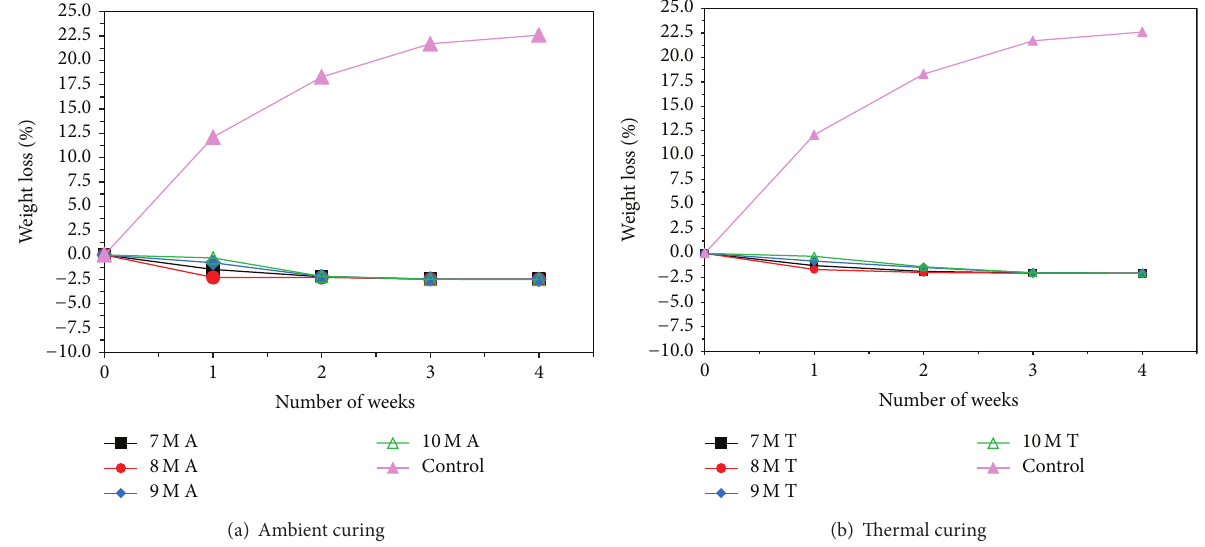
Figure 7: Weight loss for specimens immersed in 5% H 2 SO 4 after 28